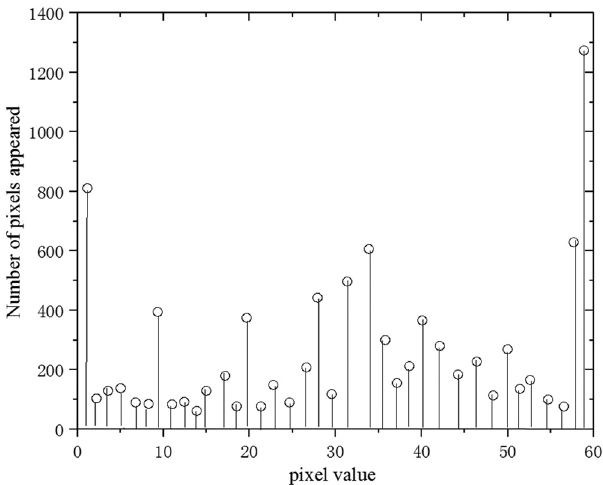
Figure 1: Histogram of the original